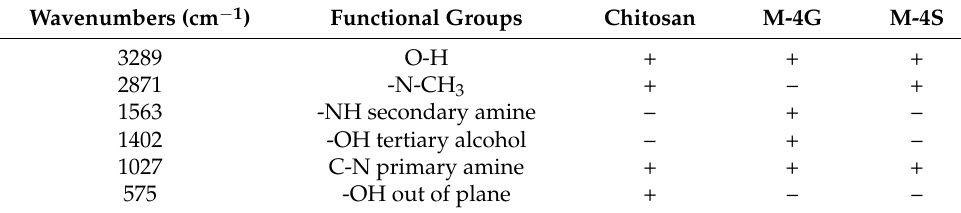
Figure 4. FTIR spectra for chitosan, MIP-glutaraldehyde (M-4G) and MIP-STPP (M-4S).